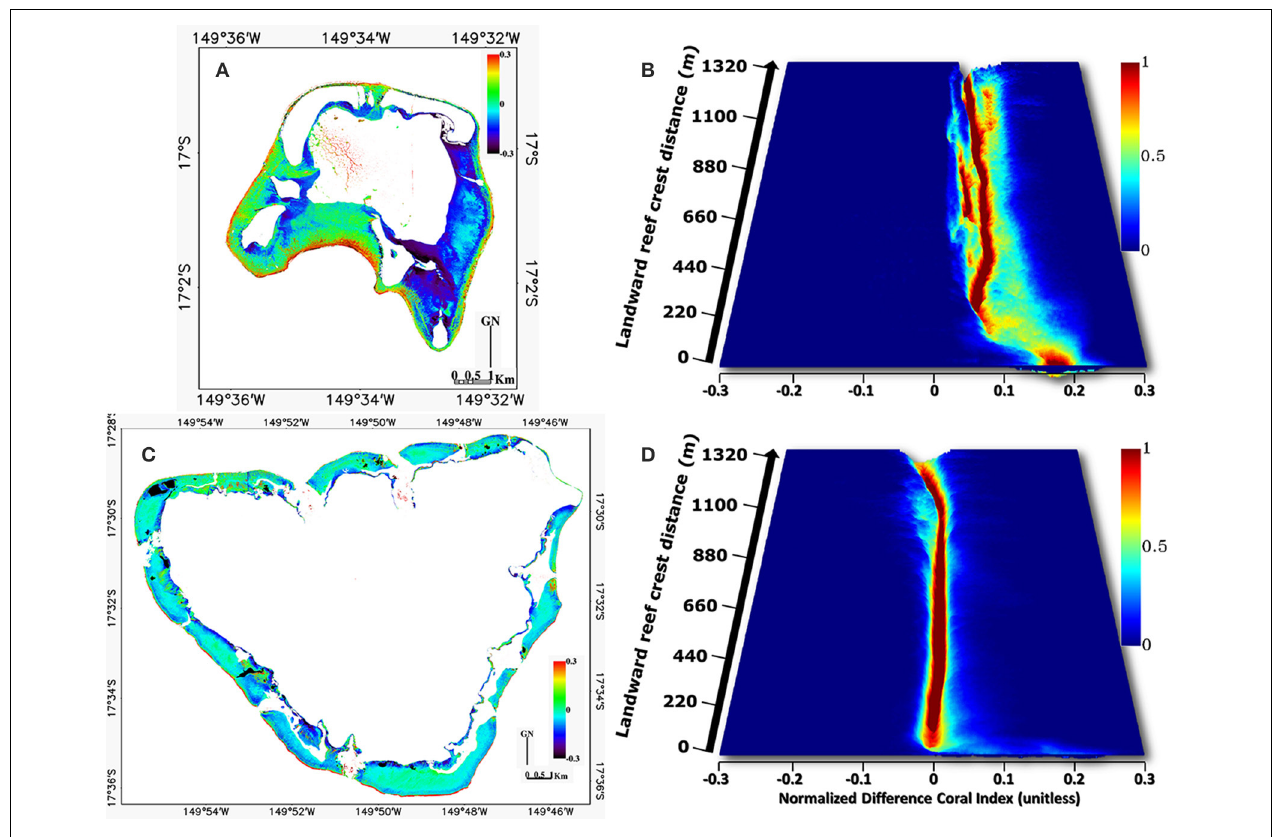
FIGURE 8 | Digital models of the Normalized Difference Coral Reef Index ( NDCRI ) based on the “red edge” and green satellite spectral bands in (A) Tetiaroa and (C) Moorea with related